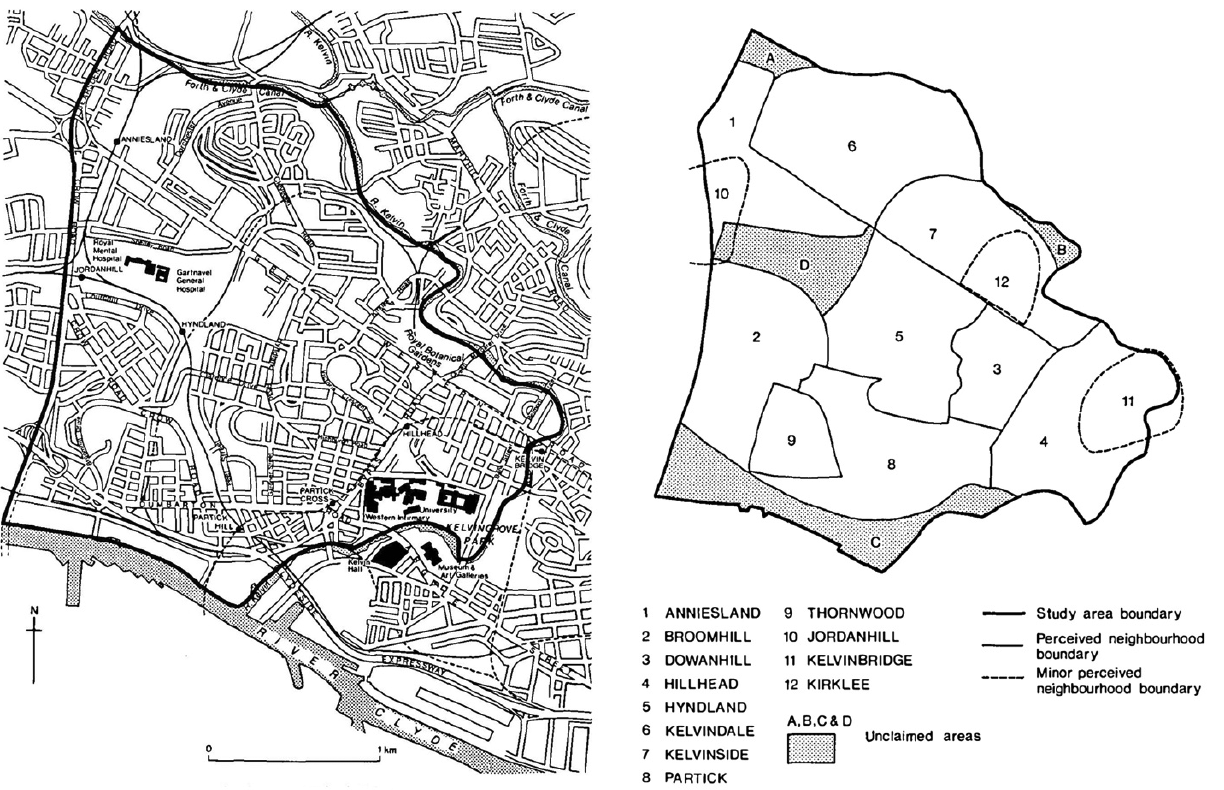
Figure 2. To the left, Gartnavel Hospital Campus location in the western part of Glasgow with the layout of the old asylum in black. To the right, Gartnavel as ‘unclaimed space’ (area D). Source: Pacione